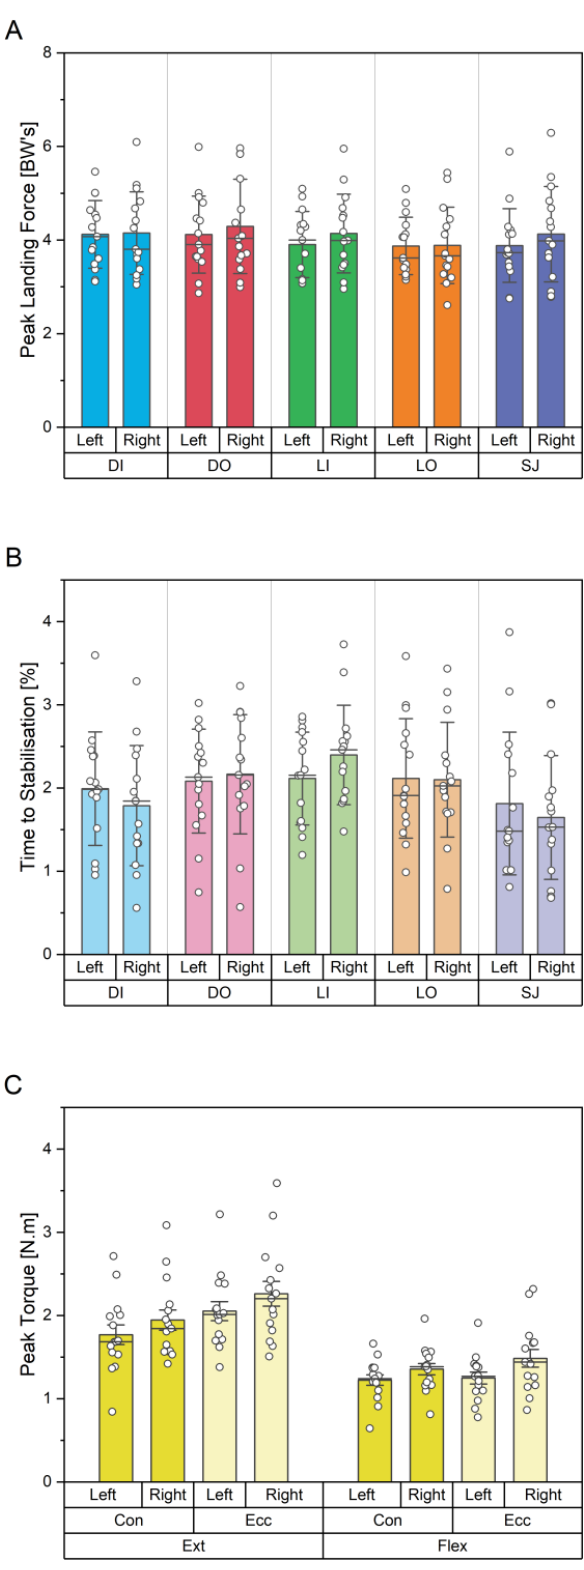
Figure 2. Summary data for peak landing force (panel A ), TTS (panel B ) and isokinetic peak torques (panel C ). DI = diagonal inside; DO = diagonal outside; LI = lateral inside; LO = lateral outside; SJ = straight jump; Con = concentric; Ecc = eccentric; Ext = extension; Flex = flexion.